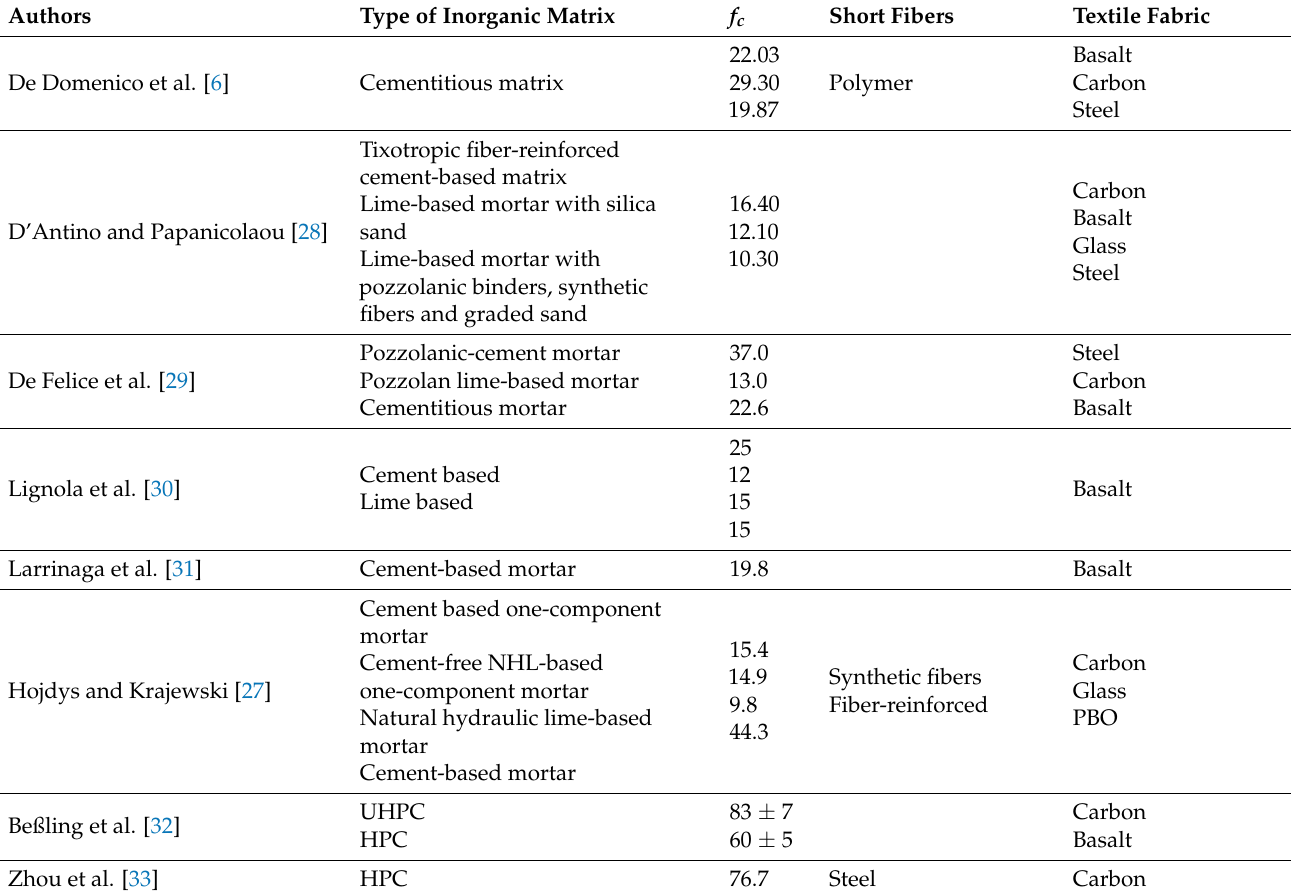
Table 1. Summary of the inorganic matrices and textile fabrics investigated in the